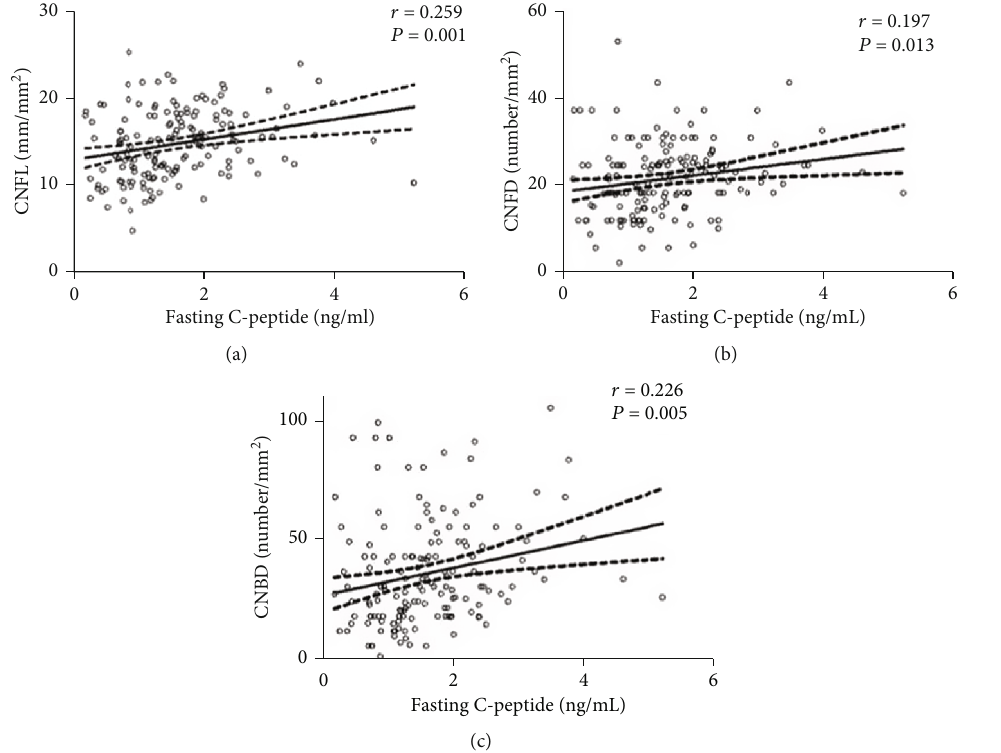
Figure 2: Correlation of fasting C-peptide levels with CNFL, CNFD, and CNBD. Table 2: Partial correlation analysis of metabolic indexes with corneal nerve parameters (adjusted for age and